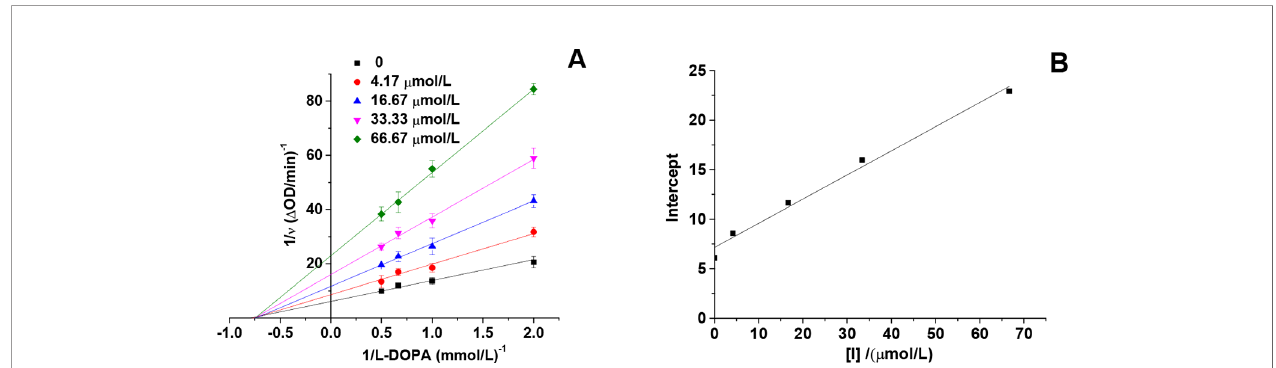
FIGURE 4 | Lineweaver-Burk plot of mushroom tyrosinase in the presence of HgCl 2 : c(tyrosinase) = 13.33 U/mL, c(HgCl 2 ) = 0, 4.17, 16.67, 33.33, and 66.67 m mol/L for curves, respectively. The experiment was repeated three times (n =